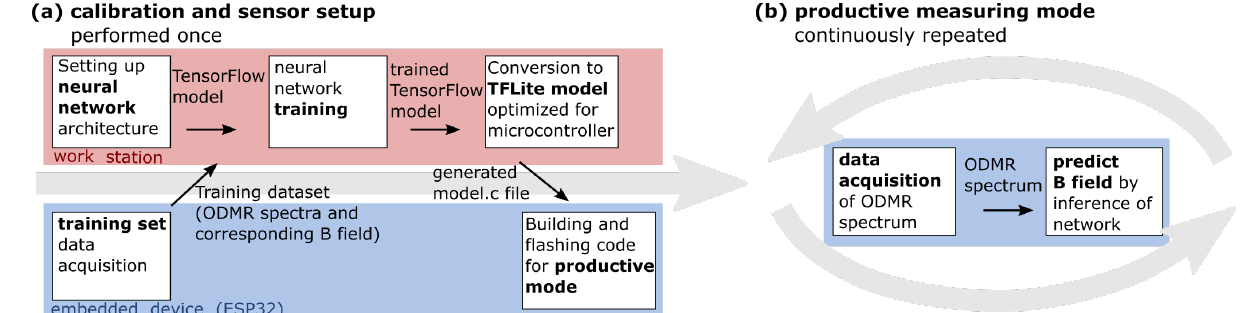
Figure 3. ( a ) Sequence of steps needed to calibrate and set up the ODMR sensor by deploying a trained edge ML model to the embedded device. ( b ) Productive measurement mode on the embedded device. One ODMR spectrum is acquired and used as input for the inference of the neural network to predict the B field. This two-step process is continuously repeated during measurement